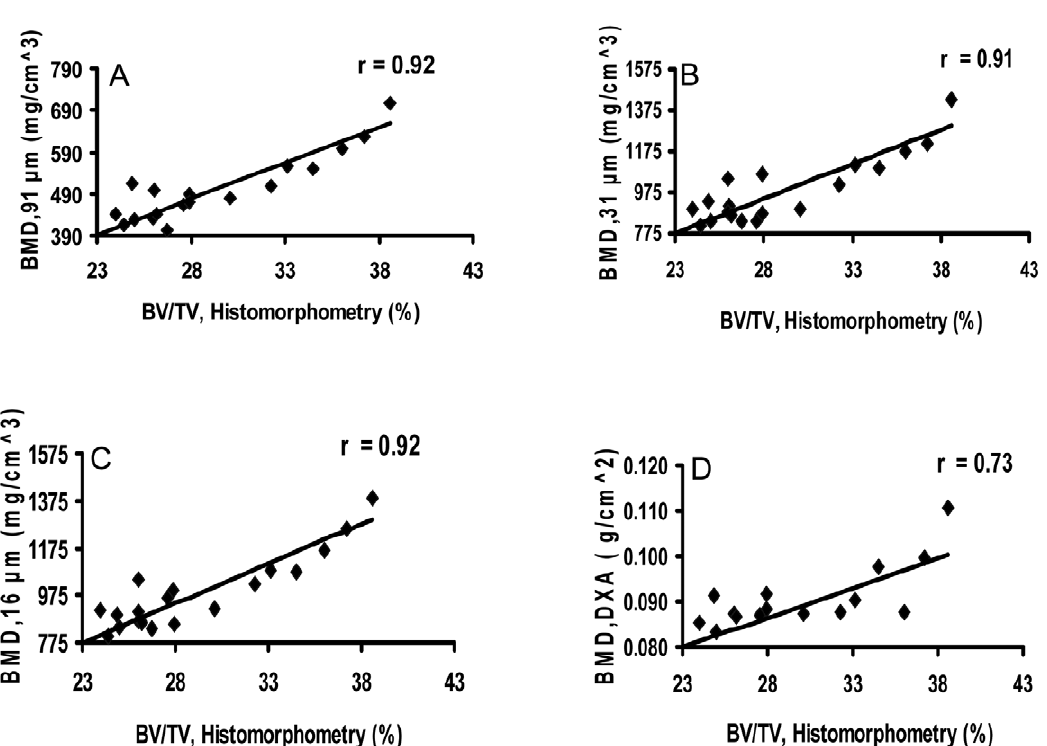
Figure 5. In vivo m CT, ex vivo specimen m CT, and DXA measurements of diaphyseal bone mineral density (BMD) correlate with histomorphometry. In vivo m CT (91- m m, A), ex vivo specimen m CT (31- m m, B; 16- m m, C), and DXA (D) measurements of bone mineral density (BMD) correlate with histomorphometric measurements of mineralized bone volume/total bone volume (BV/TV).